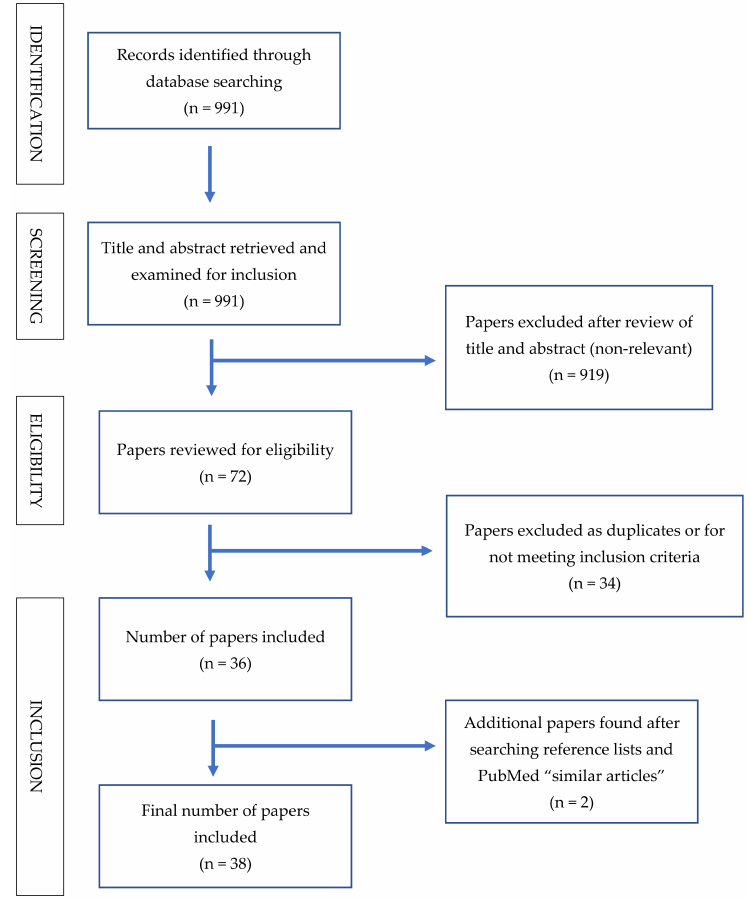
Figure 1. Search strategy and decision trail for selecting included